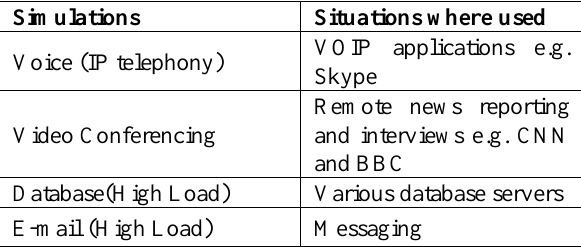
Table 1 Selected Applications and Examples of Their Uses